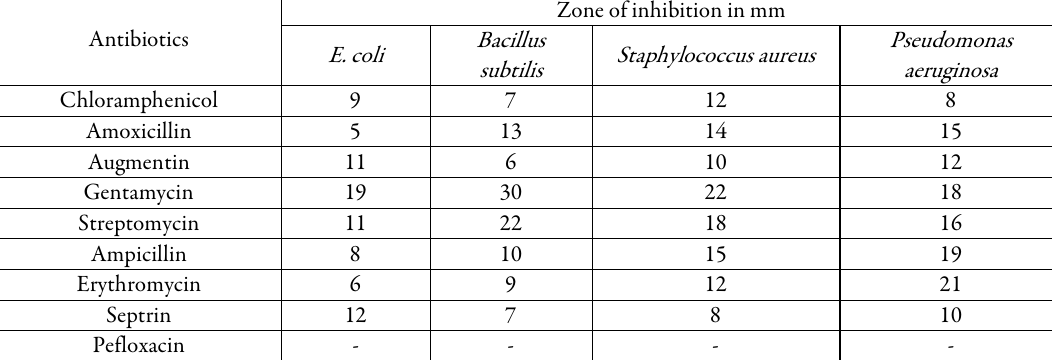
Zone of inhibition in mm